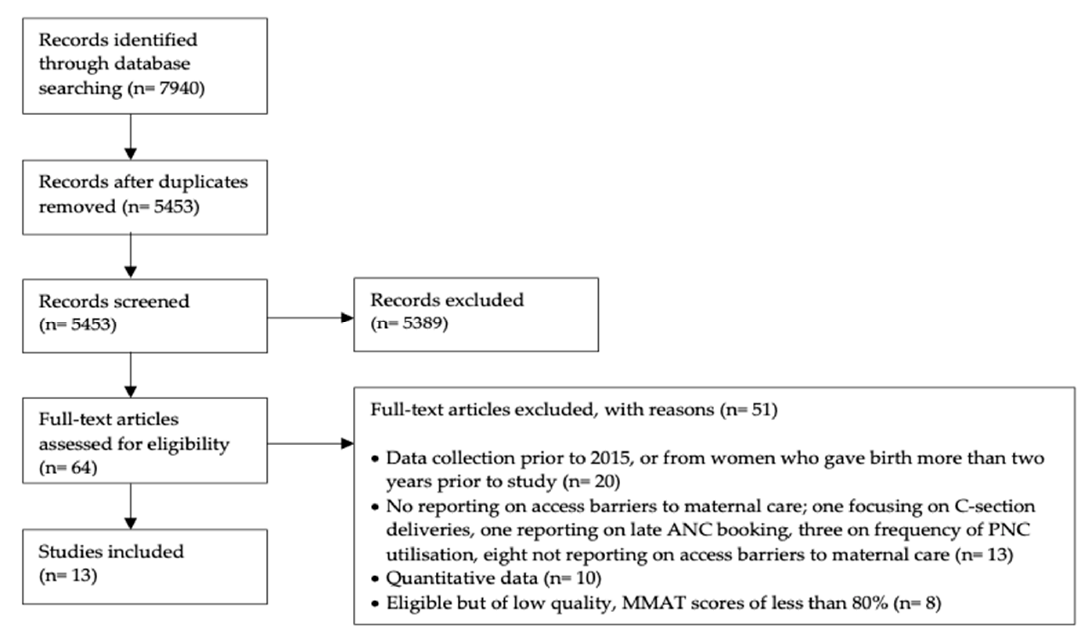
Figure 1. Prisma Flowchart. Table 2. Country Classification per publication.